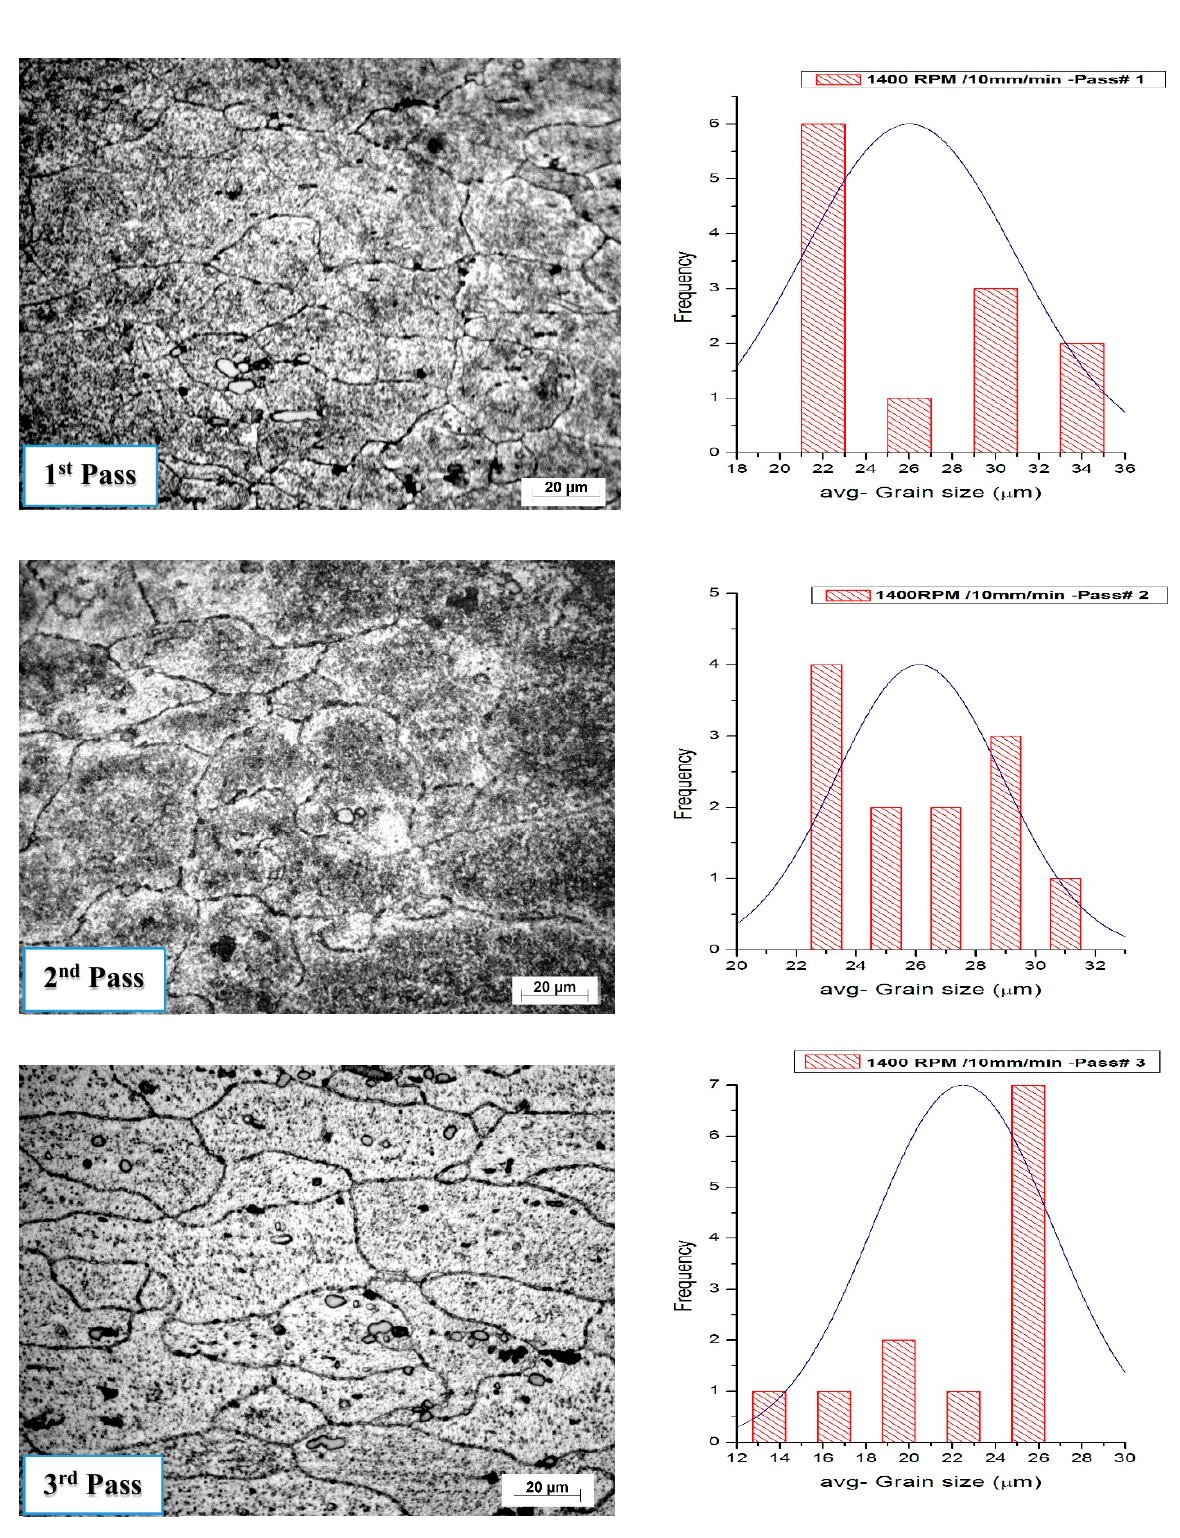
Figure 16. Optical micrographs with histogram showing grain structure and its distribution of stirring zone in friction stir processing at a 1400 rpm rotation speed and a 10 mm/min traverse speed.